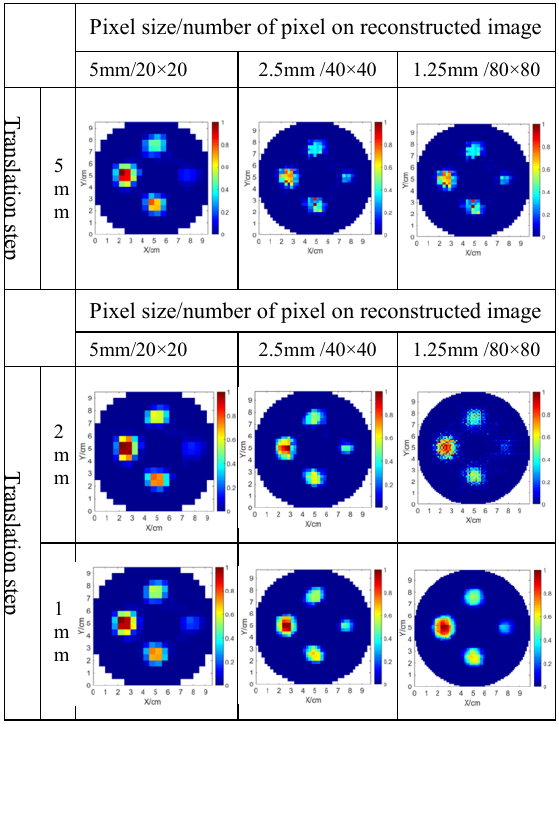
Table 2 . Reconstructed results under different pixel size on reconstructed image and translation step in each rotated